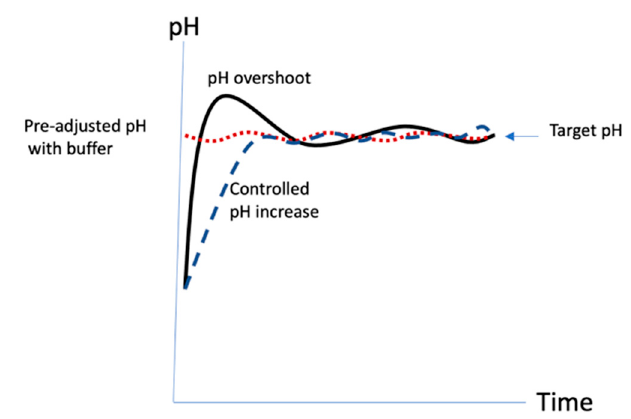
Figure 10. Modes of pH targeting for CDAP activation. Solid black line: original protocol with pH maintenance; blue dashed line: slow increase in pH using dilute base; red dotted line: Pre-adjustment of pH with DMAP.